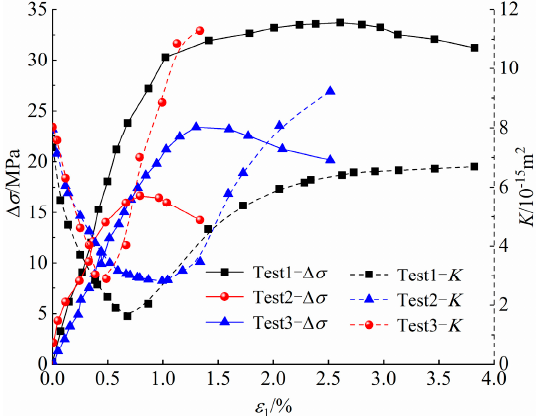
Figure 6. Variation curves of principal stress difference and permeability with axial strain during test.